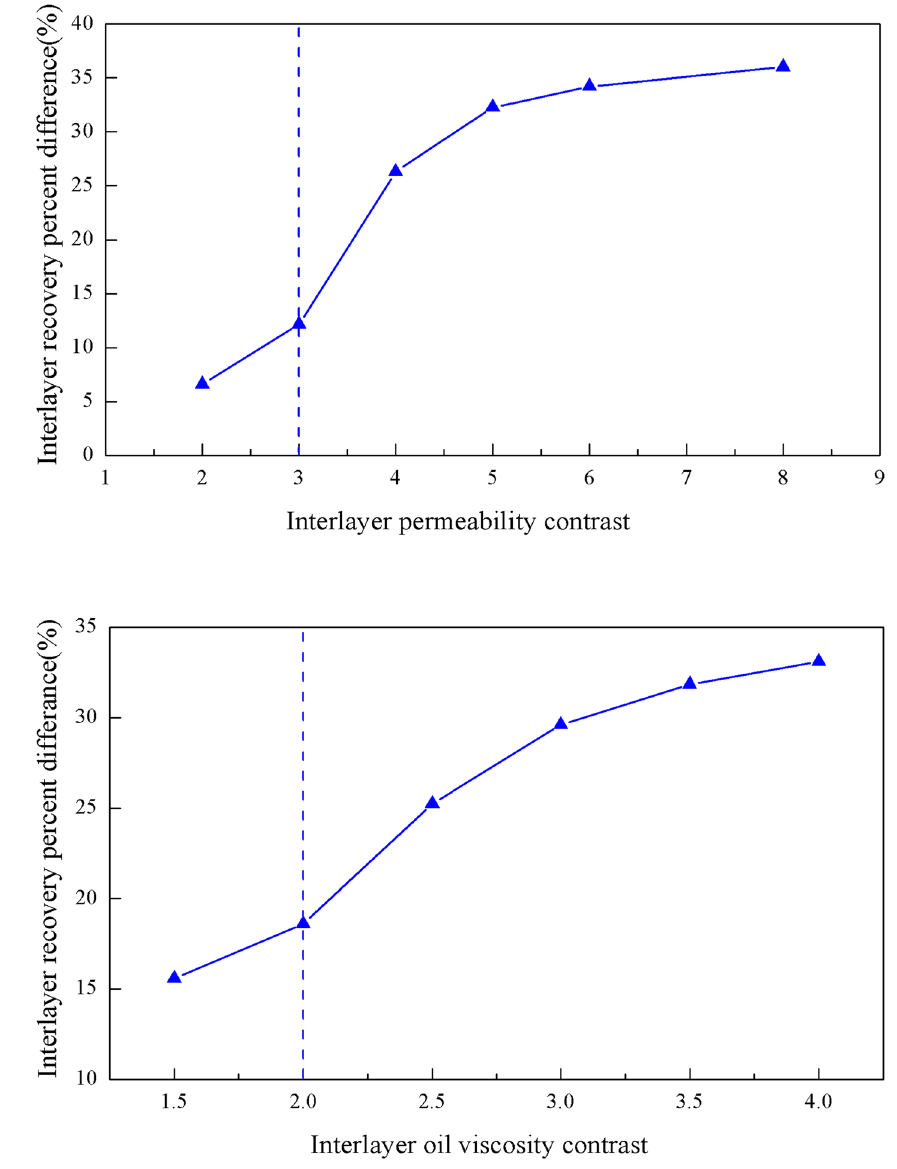
Fig. 2 Relation between inter- layer recovery percent differ- ence and permeability contrast